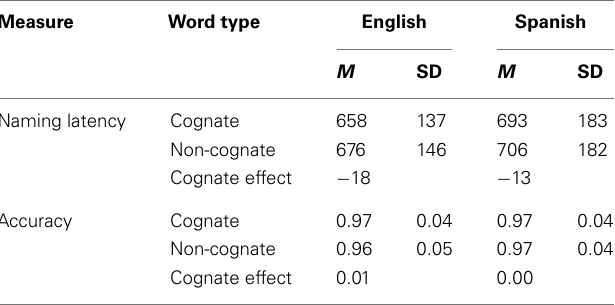
Table 4 | Blocked language